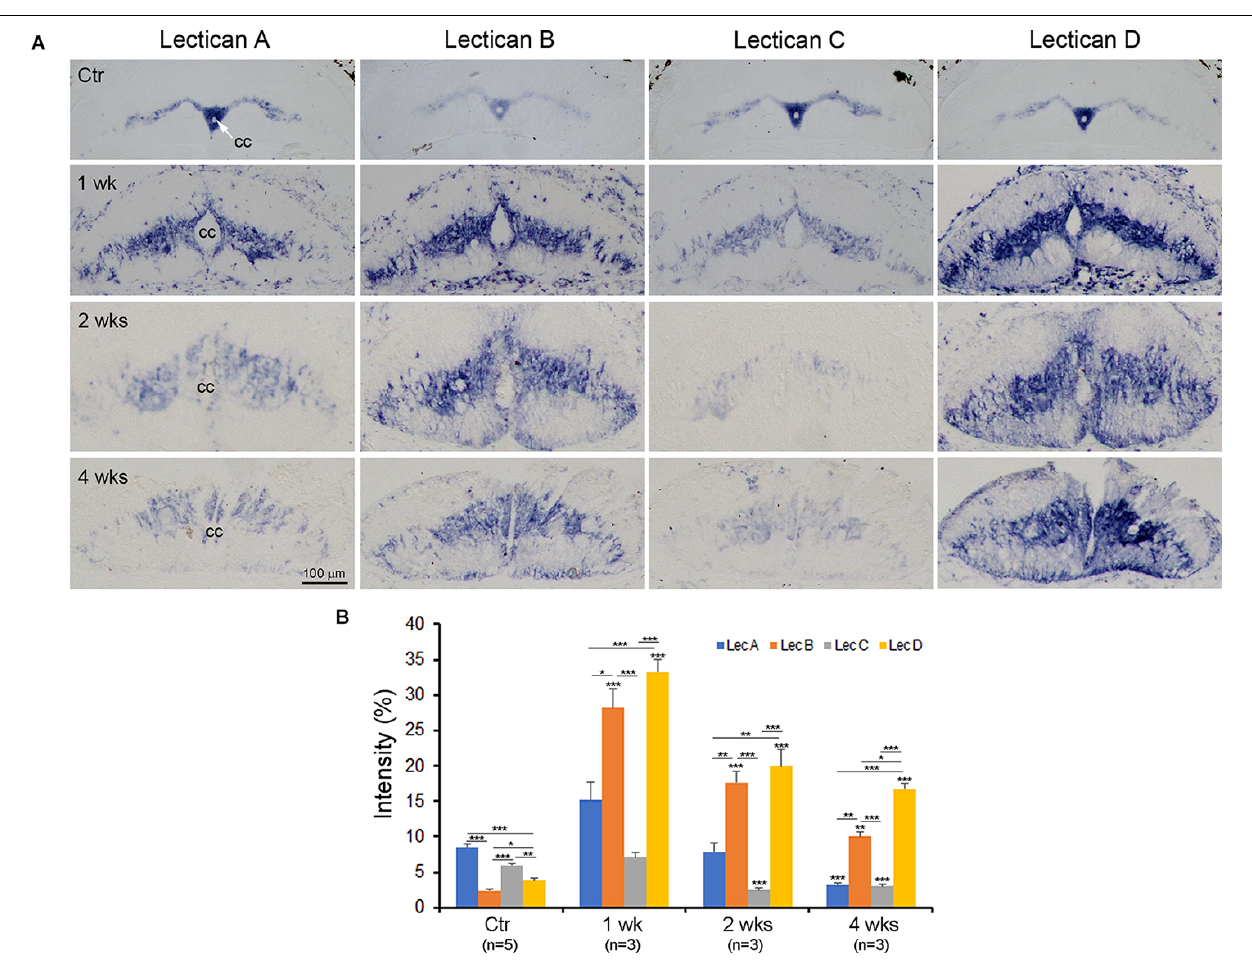
FIGURE 8 | Time course of lectican expression after SC-TX. To quantify the changes of the four lecticans after SCI, transverse sections just rostral to the TX were mounted alternately on four slides as described and ISH performed using probes LecA, LecB, LecC, and LecD, respectively (A) . As in the horizontal sections, compared to non-injured SC (top row), all four lecticans are upregulated by 1-week post-TX, then gradually decline. Lectican A and C return to levels near or lower than those of ctr SC at 2 weeks, but levels of lectican B and D remain higher than control through all time points investigated. The increase in lectican D is the most marked. The central canal (cc) is expanded after SC transection. (B) Semi-quantification of staining intensity shows the changes in the four lecticans after SC transection. n = the number of animals in each group. Five to eight sections from each animal were analyzed. Error bars indicate SEM. The intensity level of each lectican after SCI is compared with its level in control SC and within the group in each time point. Significance probabilities: * p < 0.05; ** p < 0.01; *** p <